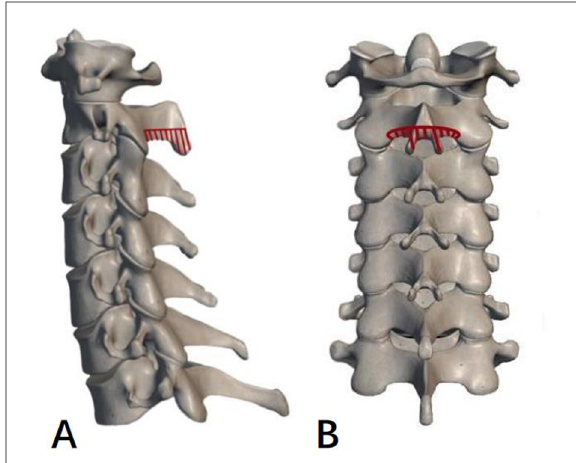
FIGURE 2 Schematic diagram of C2 partial laminectomy (C2-PL). ( A,B ) The red dottedareaisthepartofthelaminaandspinousprocesstoberesected.